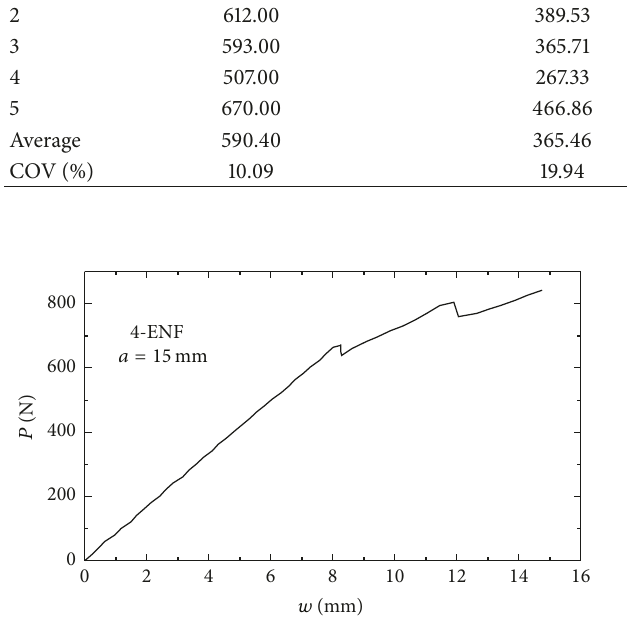
Figure6:Typicalload-displacementcurvefor4-ENFGFRPbonded specimens.